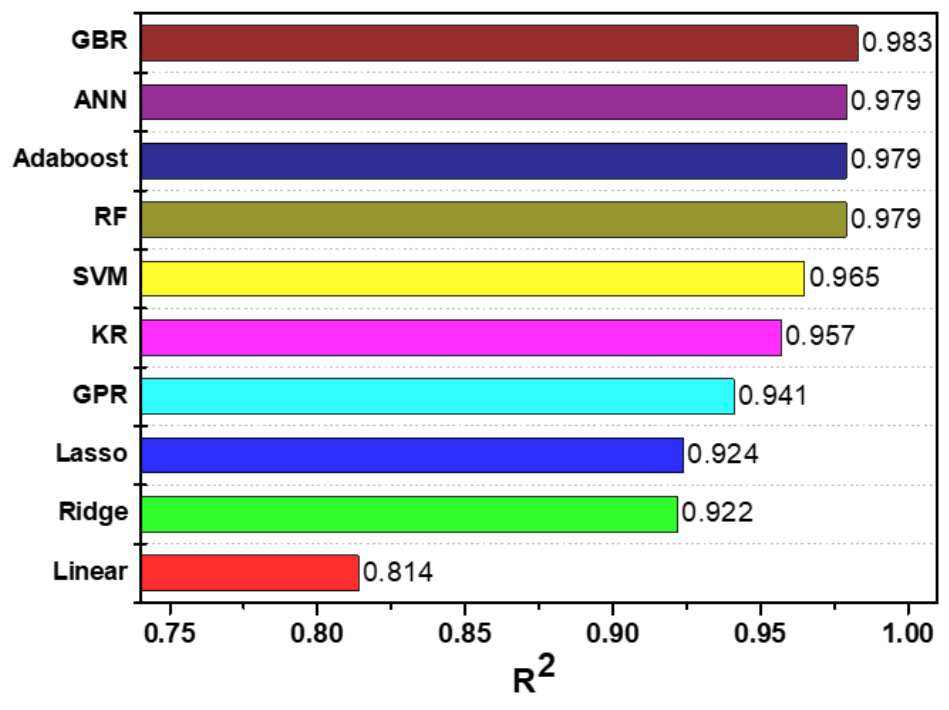
Figure 3. Performance analysis of machine learning models. Table 2. Proposed machine learning regressors and the resulting attenuation